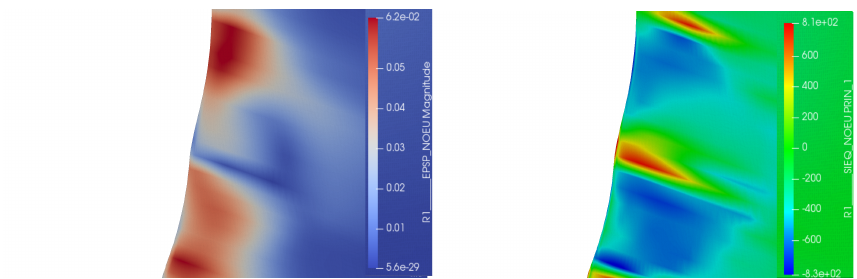
Figure 2. Plastic deformation and stress state induced by the first 2